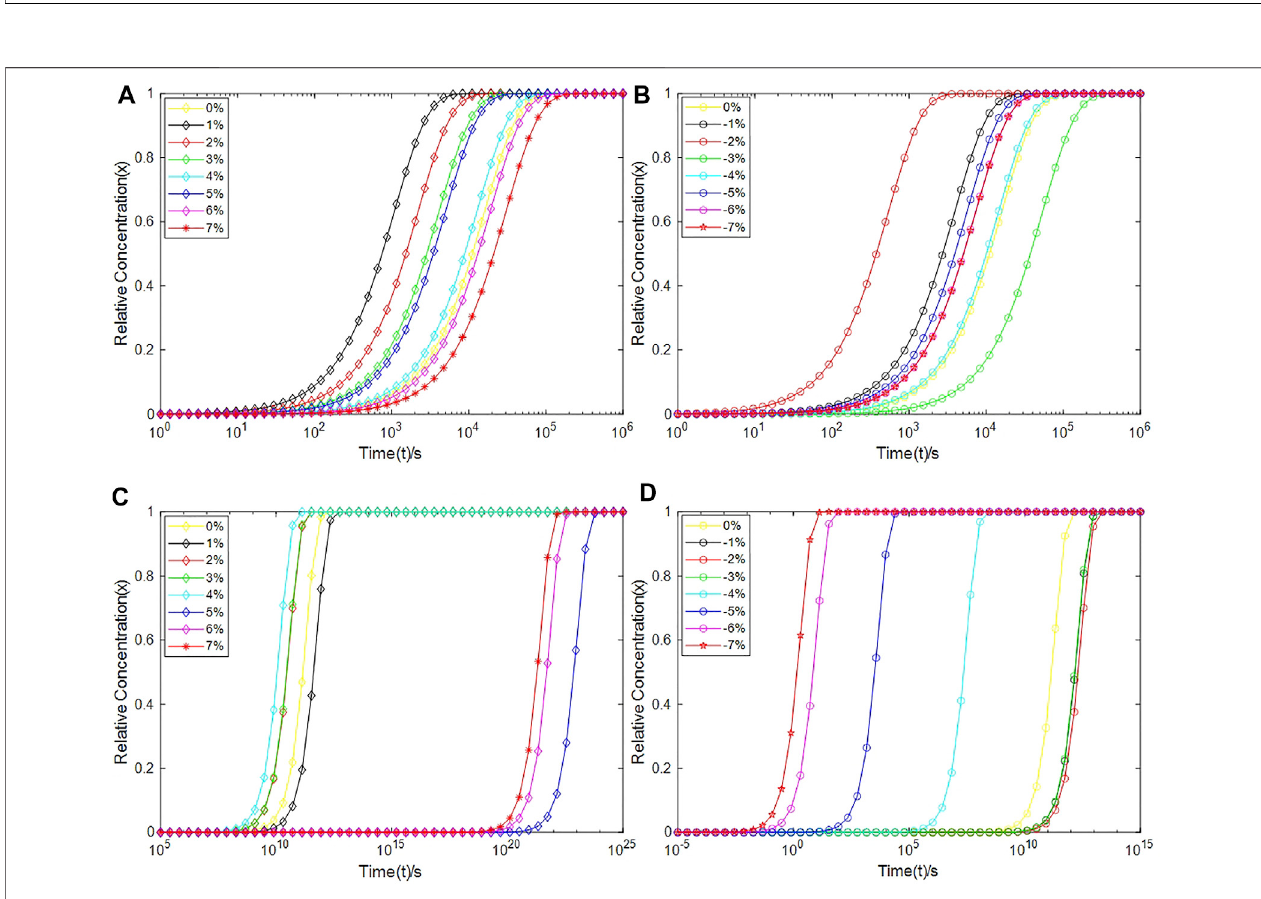
FIGURE 11 | The relative concentrations of P b+ and P b1+ as a function of time during depassivation processes. (A) The relative concentration of P b1+ under tensile strains, (B) Therelativeconcentrationof P b1+ under compressive strains, (C) Therelative concentration of P b+ under tensile strains, and (D) The relative concentrationof P b+ under compressive